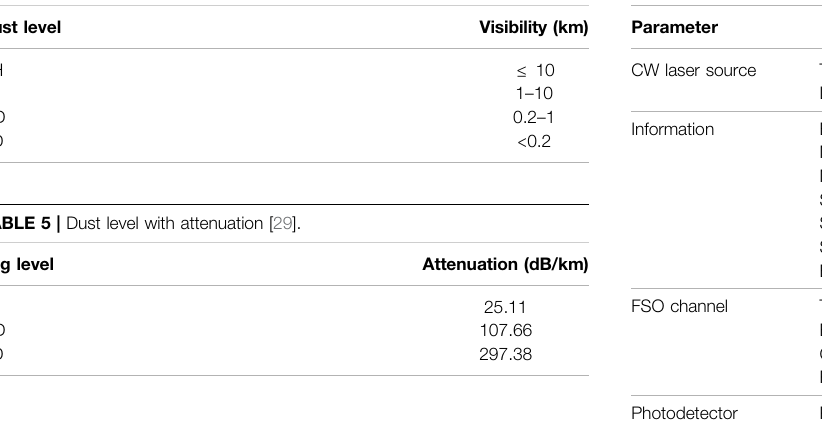
TABLE 6 | Simulation parameters [24, 40 –